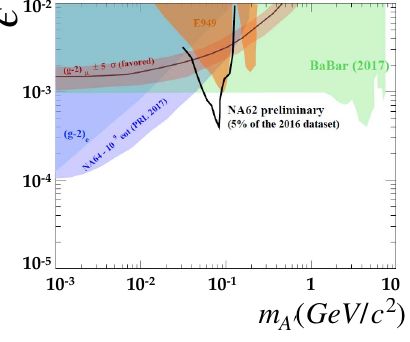
Figure 3. 90% C.L. Upper Limit (UL) in the plane of coupling | U 4 l | versus mass.